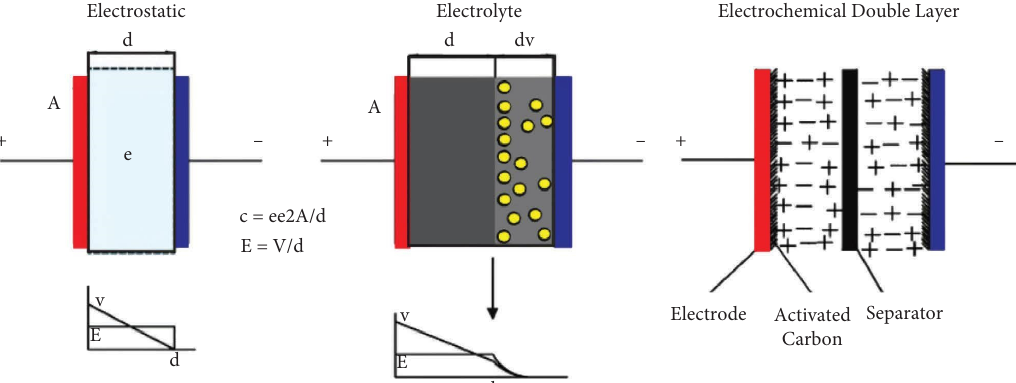
Figure 2: Schematic of electrostatic capacitor, electrolytic capacitor, and electrical double-layered capacitor (self-made). Table 1: Details of voltage window of diferent electrolytes [90]. Sr.